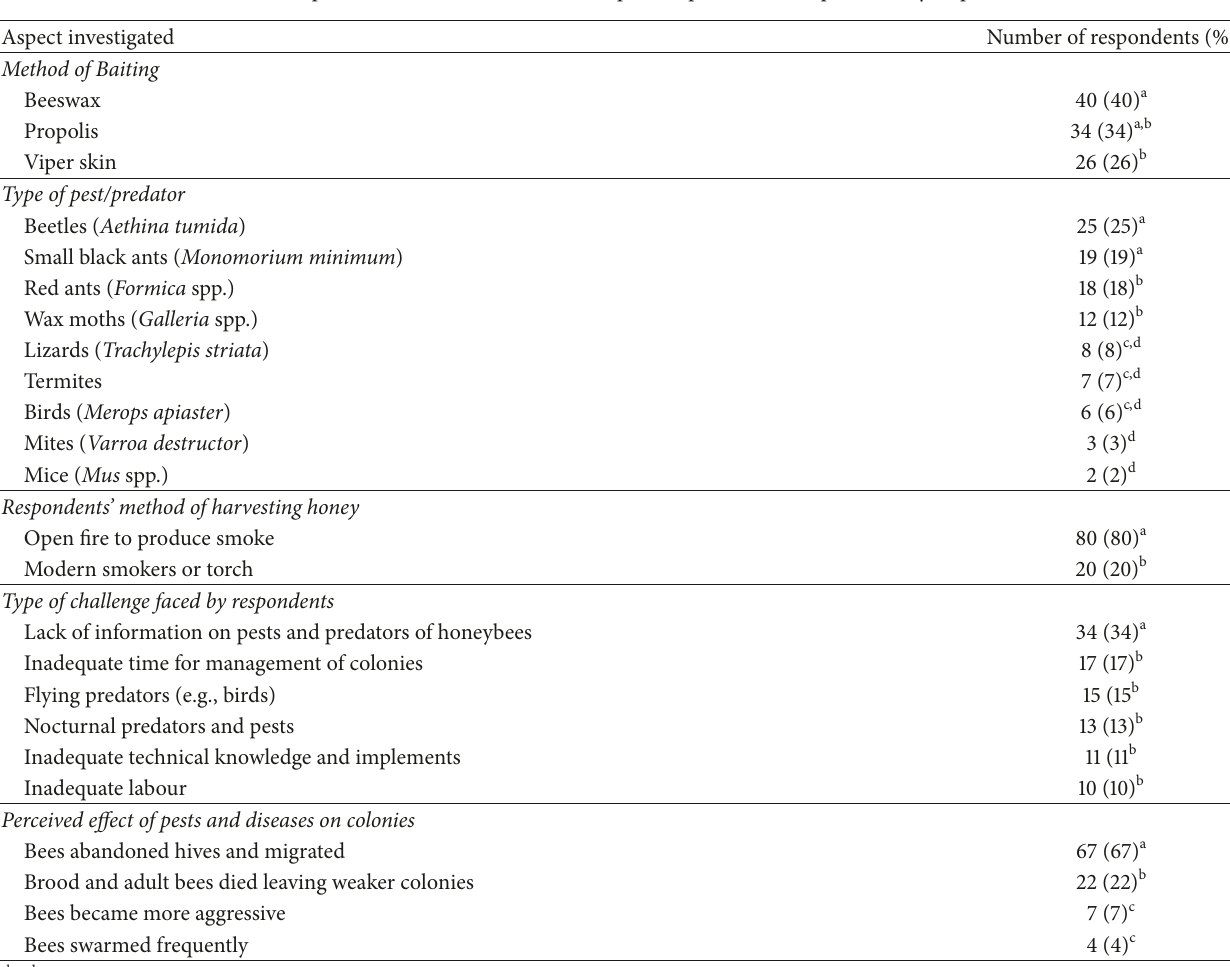
Table 10: Proportional occurrence of various aspects experienced and practised by